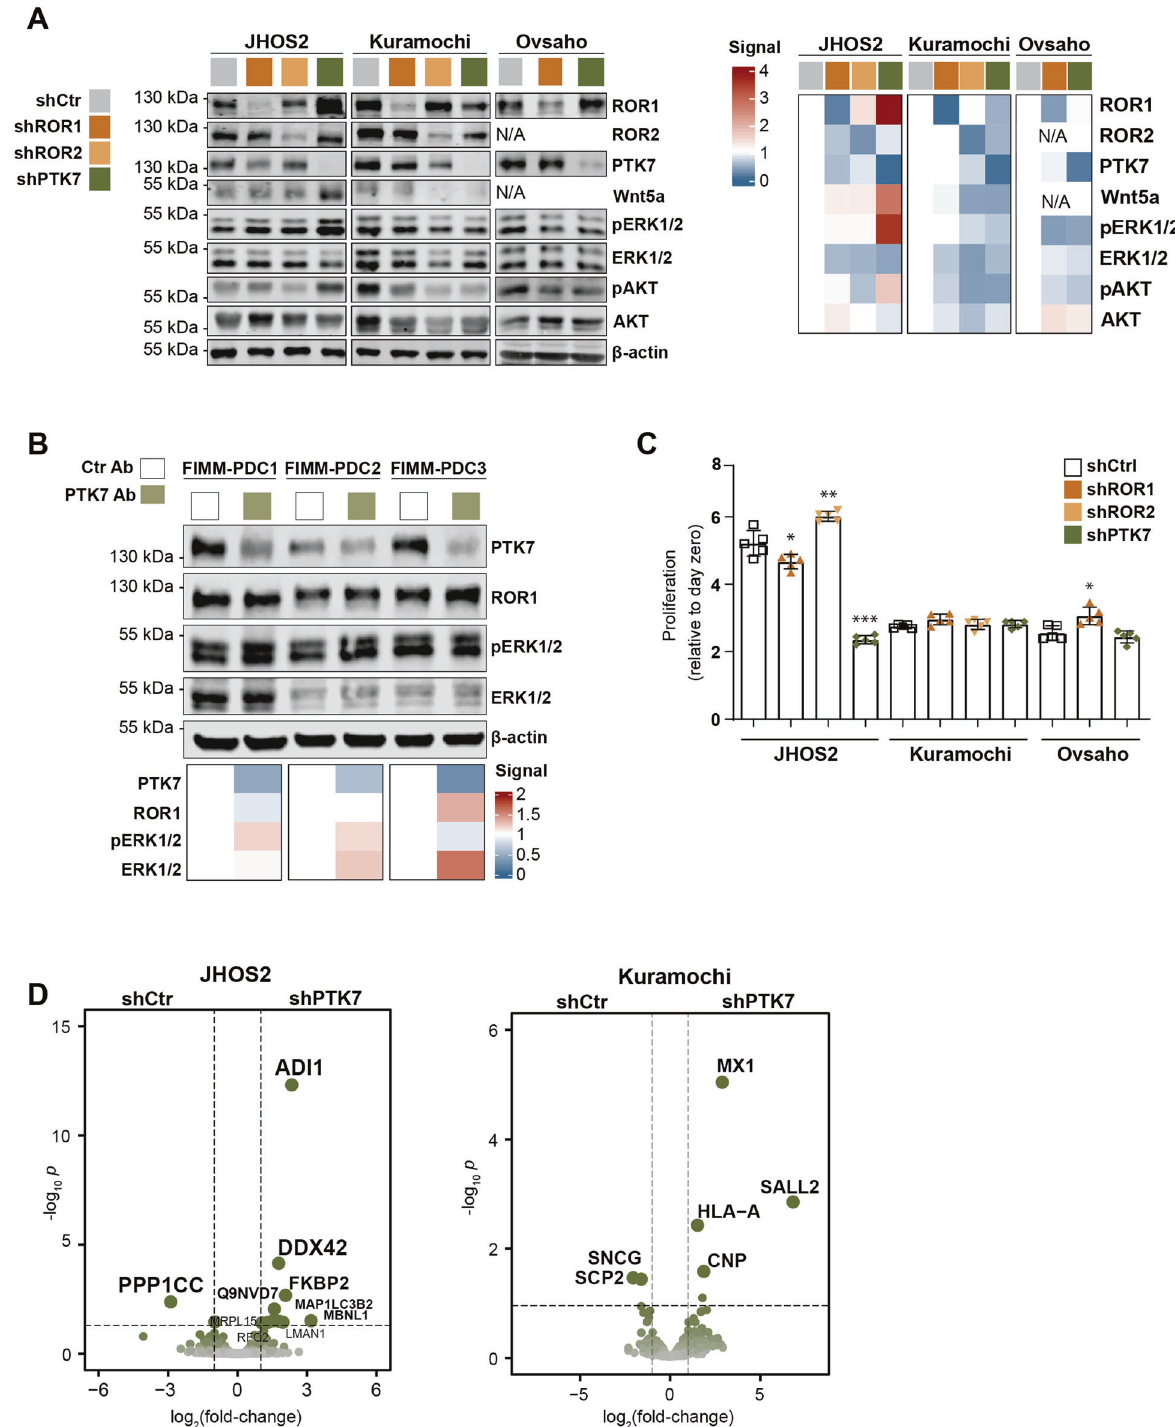
Fig. 2 Proteomics data analysis identi fi es downstream effectors of PTK7 in OC. A Immunoblot analysis of DOX-treated (4 days) JHOS2, Kuramochi, and Ovsaho shRNA cell lysates. Protein levels were normalized fi rst based on β -actin, which was used as loading control, and then to shCtr samples for each cell line (set as 1). A representative of 3 independent experiments is shown. B Immunoblot analysis of FIMM-PDC1-3 cell lysates treated with control or PTK7 mAb cofetuzumab (10 µg/ml) for 48 h. For signal quanti fi cation, protein levels were normalized based on β -actin that was used as loading control. C Cell viability assay of DOX-treated (7 days) shRNA cell lines. Graphs show mean ( n = 4 biological replicates) ± SD; p- values (two-tailed Student´s t -test): * p ≤ 0.05, ** p ≤ 0.01, *** p ≤ 0.001. D Volcano plots showing the distribution of the protein level fold-changes and p -values for the comparisons of differentially expressed proteins (DEPs) in shPTK7 vs. shCtr samples for each cell line; p < 0.05.